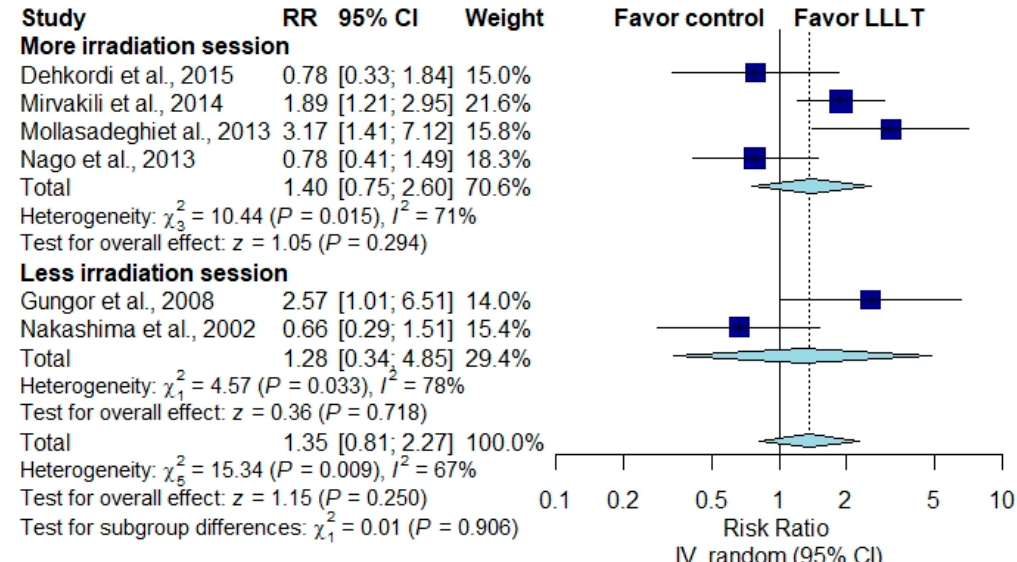
Figure 6. Subgroup analysis of THI scores according to the number of irradiation sessions [1,28–31] .